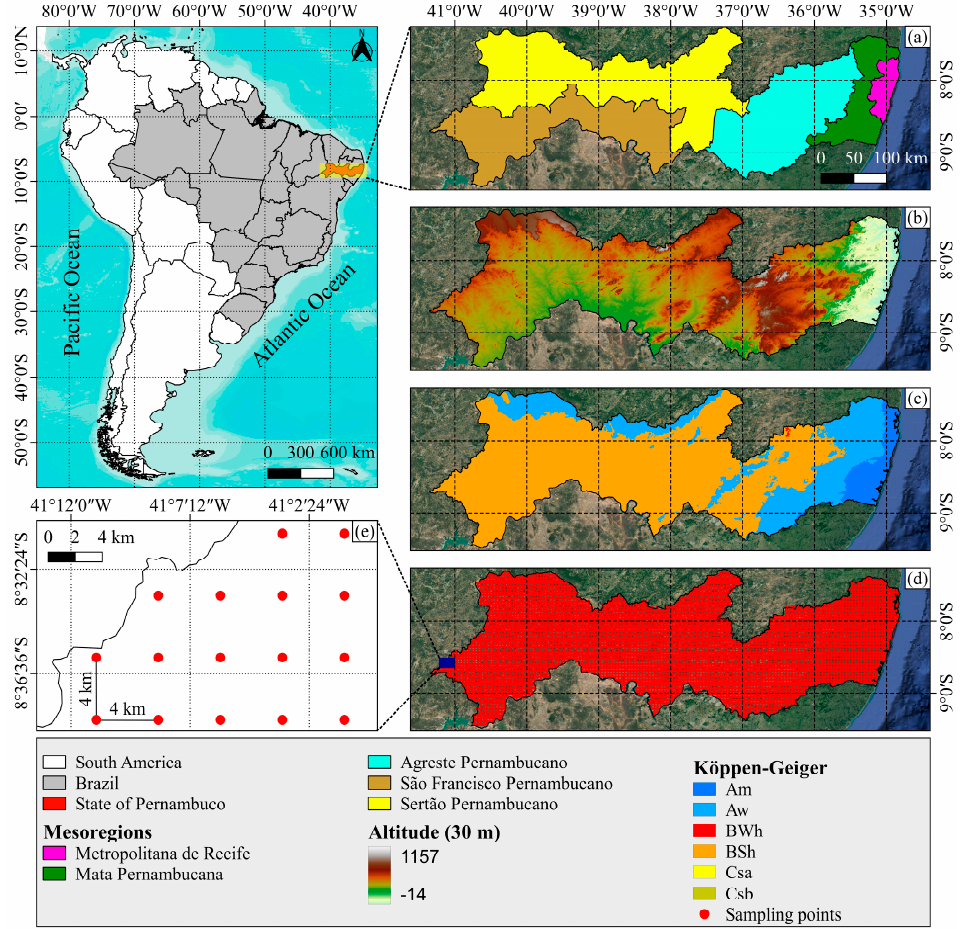
Figure 1. ( a ) Location of the study area. ( b ) Digital elevation in meters, based on Shuttle Radar Topography Mission (SRTM) data. ( c ) Climatic zones according to the Köppen–Geiger climate classification. ( d ) Sampling grid obtained from TerraClimate. ( e ) Sampling points with spatial resolution of 4 km (1/24°).